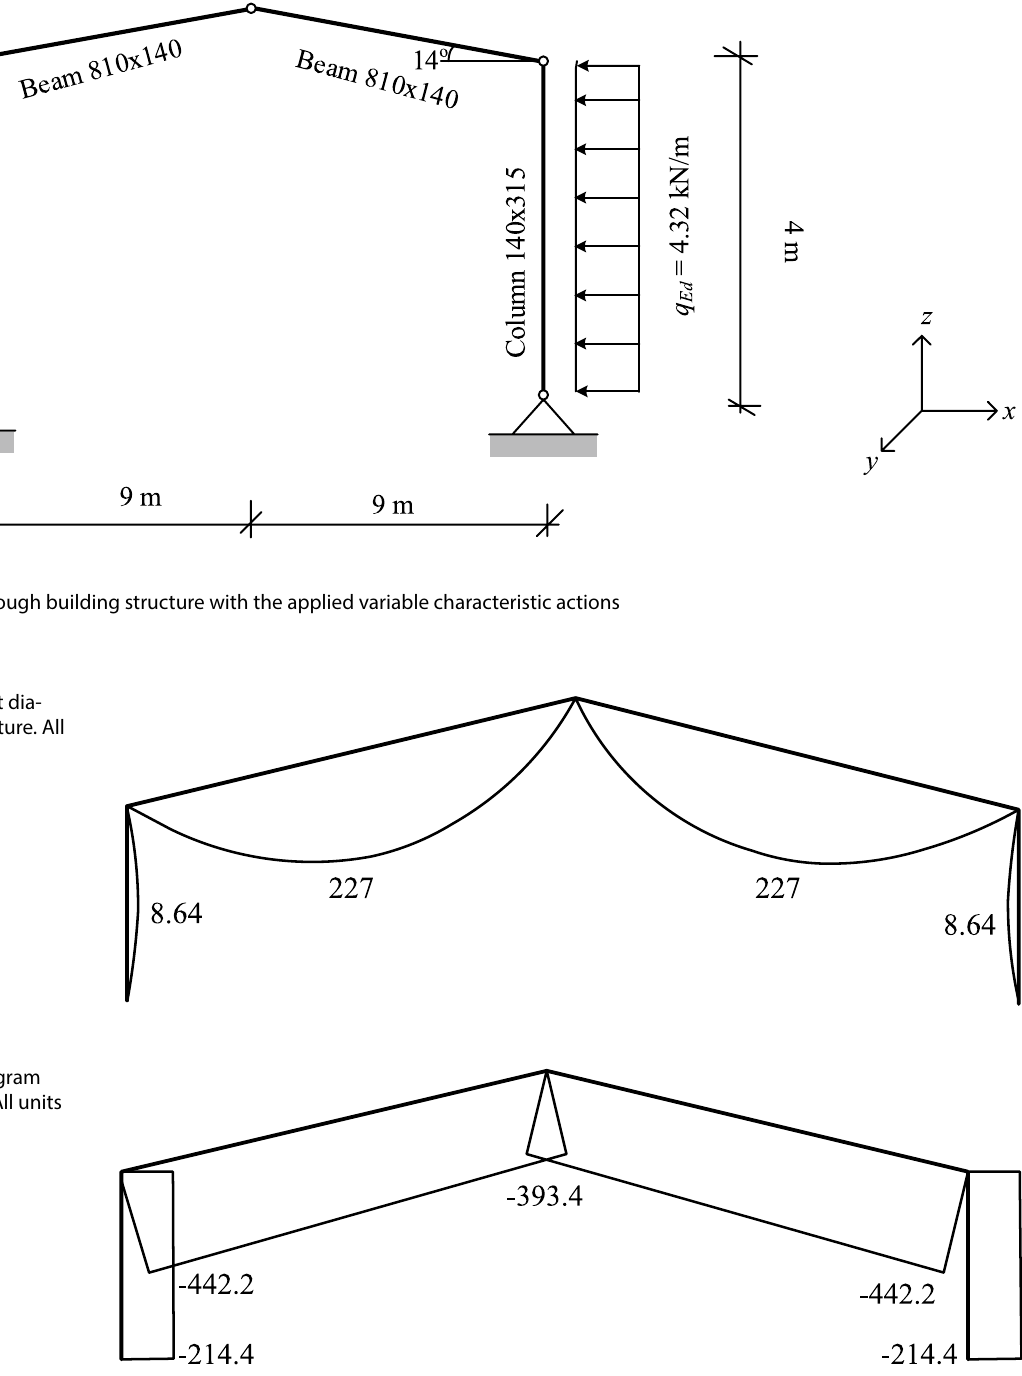
Fig. 5 Normal force diagram of the frame structure. All units are